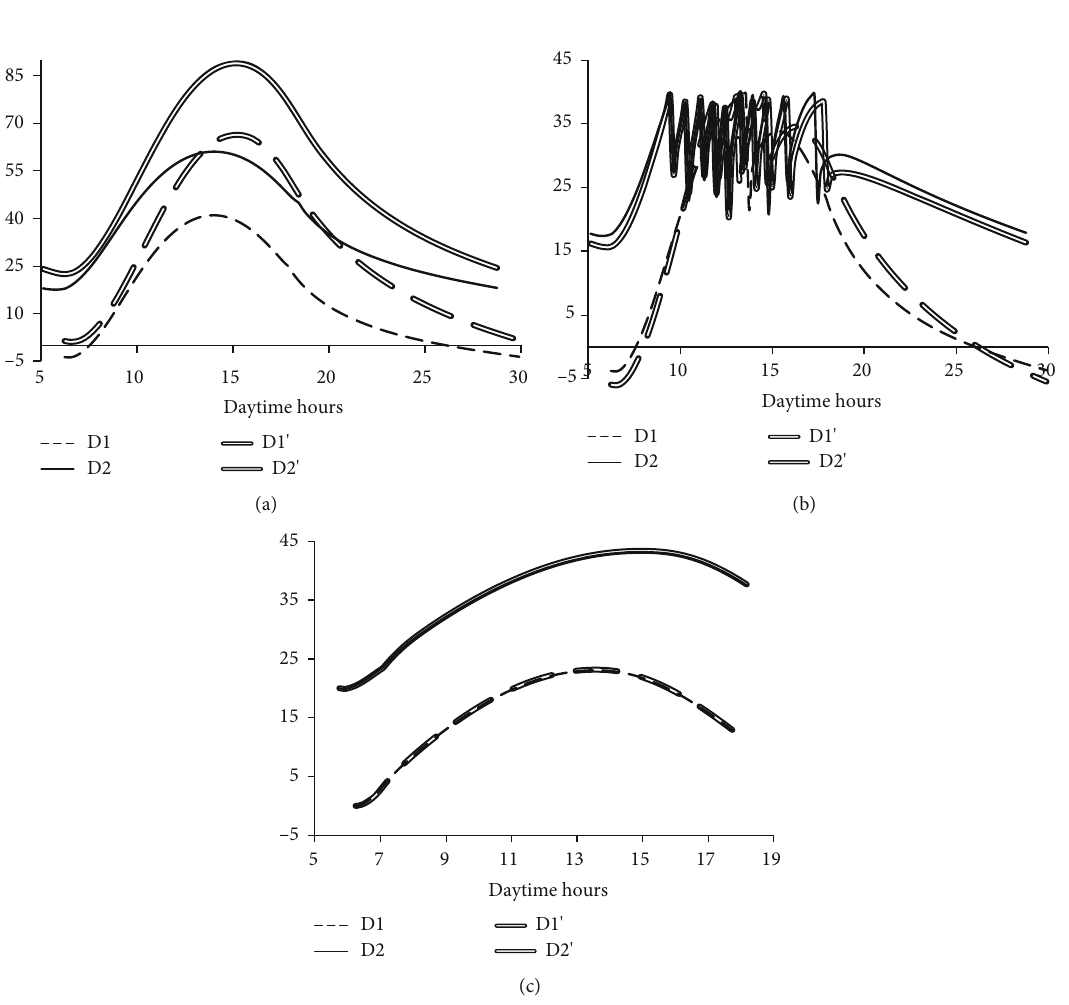
Figure 4: Calculated daily dynamics of water temperature: (a) M1, (b) M2, (c) M3; ′ means that the device is